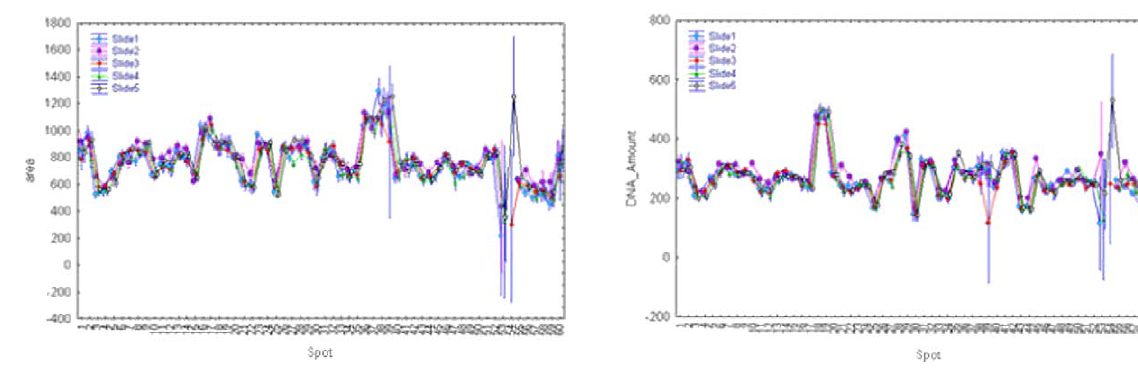
Fig. 5. Five different slides showing the variation of mean DNA amount per dot per slide.